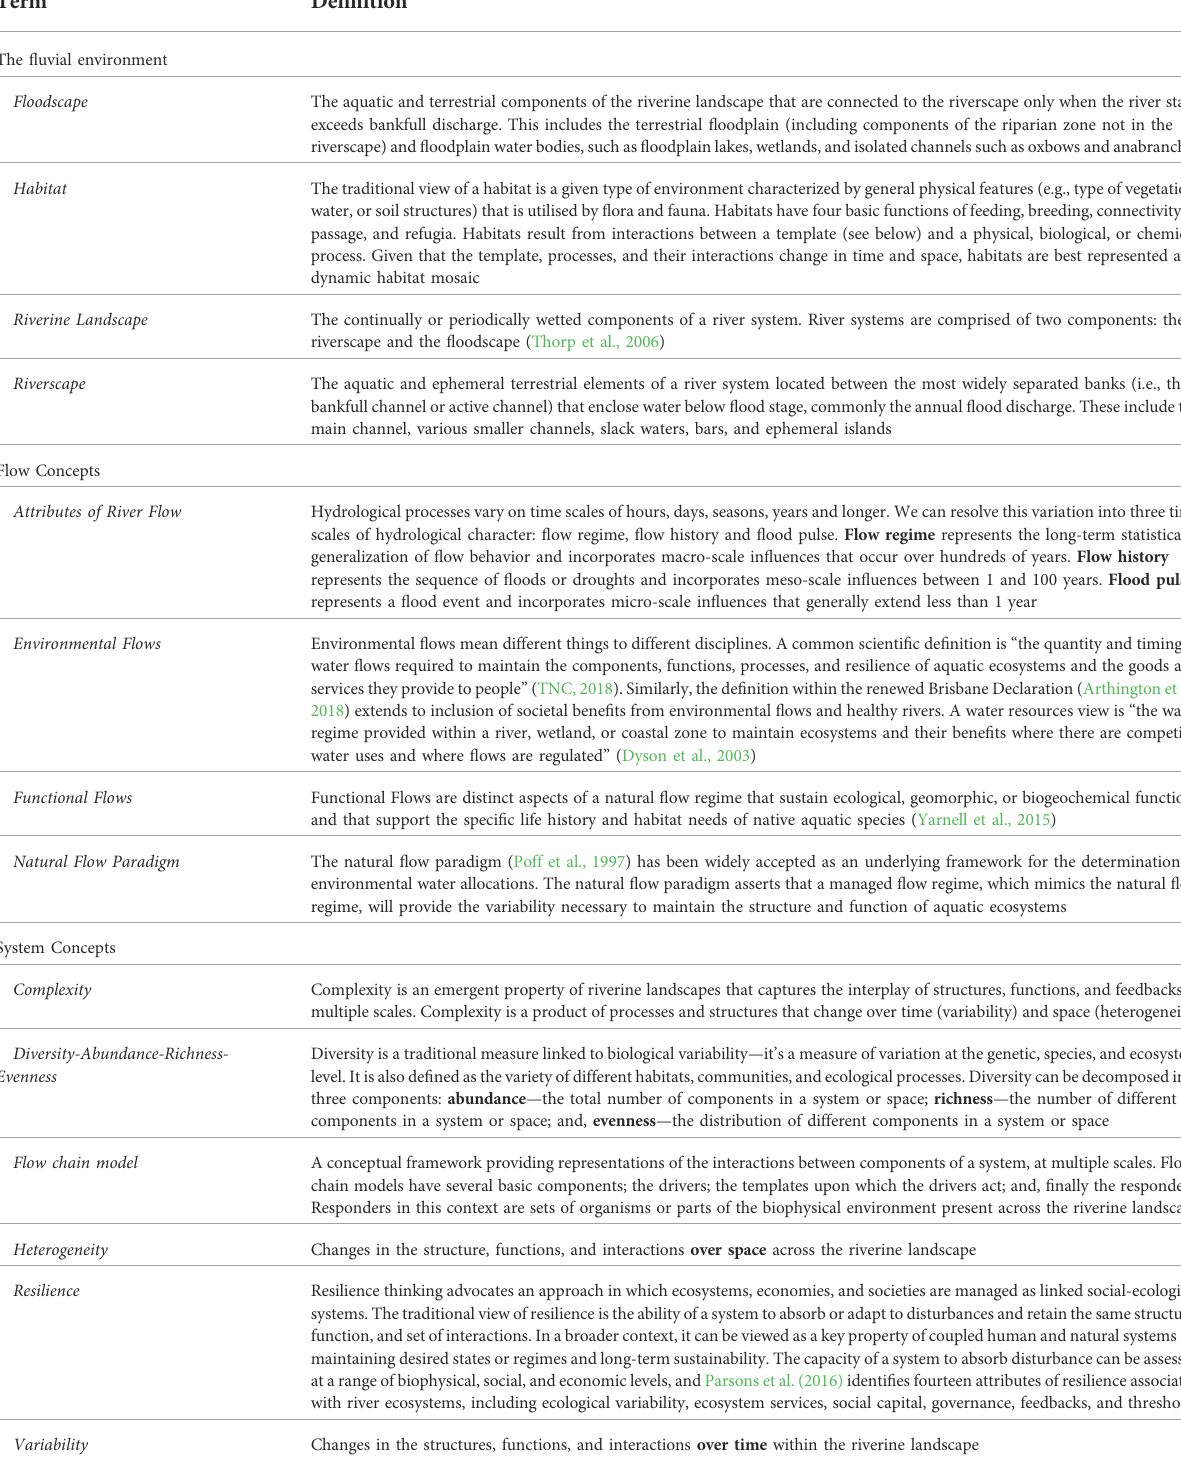
TABLE 1 Terminology for the fl uvial environment, fl ow concepts, and system